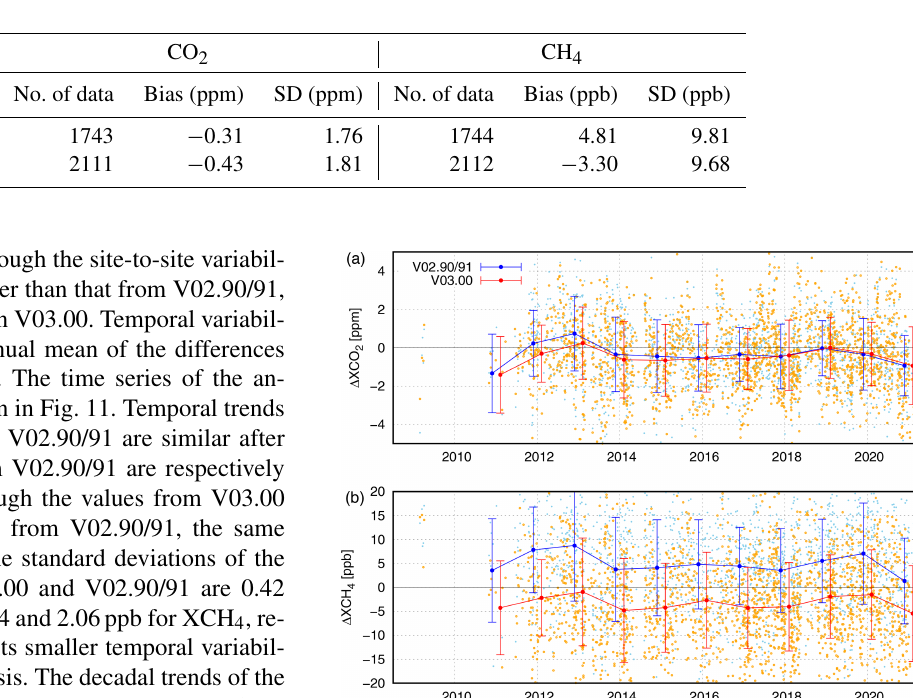
Table 7. Validation results of V03.00 and V02.90/91 over land with gain H against the TCCON measurement version GGG2020 in the match-up condition of ± 0.1 ◦ .